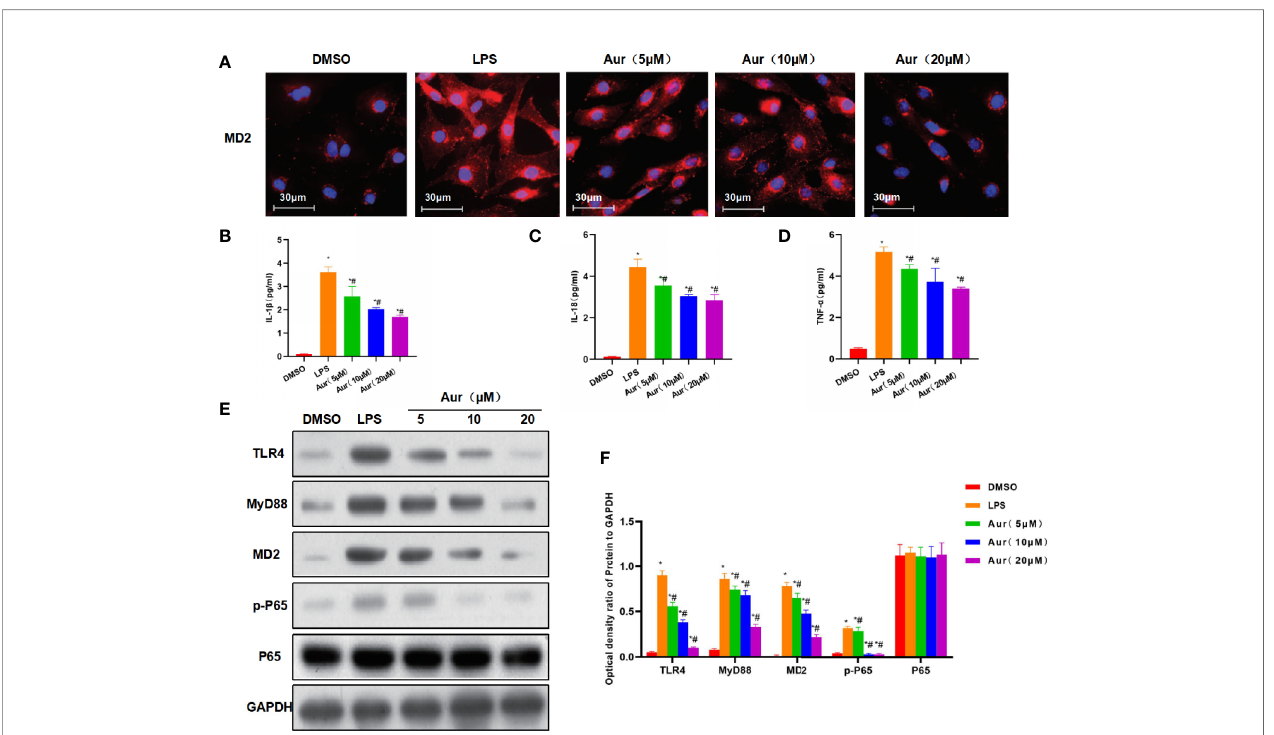
FIGURE 2 | The mechanism of the inhibitory roles of Aur on inhibiting KC injury. (A) : IF staining of MD2 protein (n = 3): The expression level of MD2 was relatively low in the DMSO group, which was signi fi cantly increased in the LPS group, with higher increased fl uorescence intensity than the DMSO group. While Aur treatment could inhibit the expression of the MD2 protein, the fl uorescence intensity was downregulated, which were signi fi cantly different from LPS treatment. (B – D) : Detection of in fl ammatory factors (n = 3): The levels of in fl ammatory factors, including IL-18, IL-1 b , and TNF- a were relatively low in the DMSO group, which were signi fi cantly upregulated by LPS treatment; while Aur treatment could suppress the levels of in fl ammatory factors. Comparison with DMSO, *P <0.05; comparison with LPS group, # P <0.05. (E, F) : The expression of key proteins of the TLR4/MD2-NF- k B signal (n = 3): The expression levels of TLR4, MyD88, MD2, and p-P65 were signi fi cantly more upregulated after LPS induction than DMSO treatment, while the expression of P65 was not signi fi cantly changed. Aur treatment could downregulate the expression of TLR4, MyD88, MD2, and p-P65 in a dose-dependent manner, while the expression of P65 was not signi fi cantly changed. Comparison with DMSO, *P <0.05; comparison with LPS group, # P